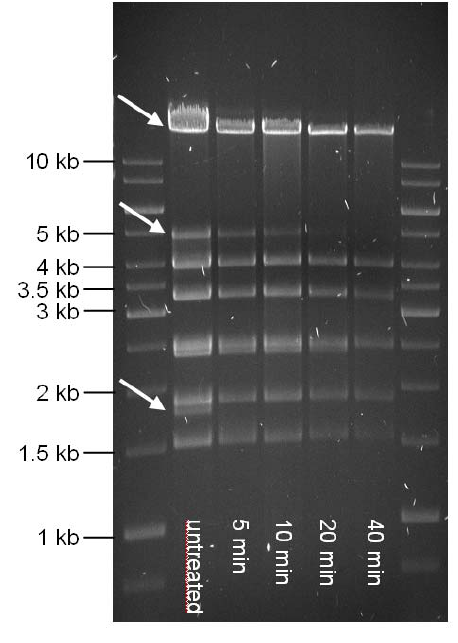
Figure 4. Gel electrophoresis of TP21-L DNA predigested with Bal31 nuclease (New England Biolabs), phenolized and subsequently digested with PvuI restriction endonuclease (Fermentas). Marker: 1kb Marker (Fermentas). Other lanes: untreated DNA and PvuI digest of DNA pretreated with Bal31 for indicated time. Arrows indicate fragments disappearing over